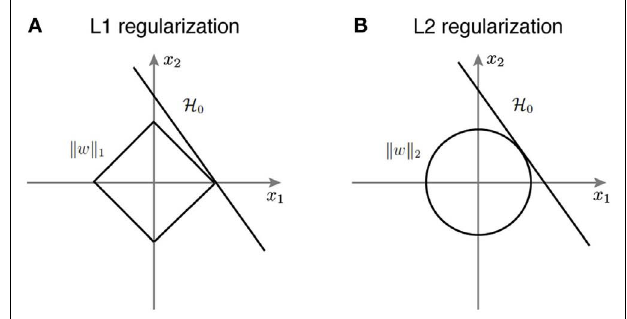
FIGURE 3 |A schematic illustration of how different regularization terms lead to sparse and non-sparse solutions in the linear classifier. (A) L1 regularization corresponds to the diamond shaped ball centered around the origin. (B) L2 regularization corresponds to the spherical ball centered around the